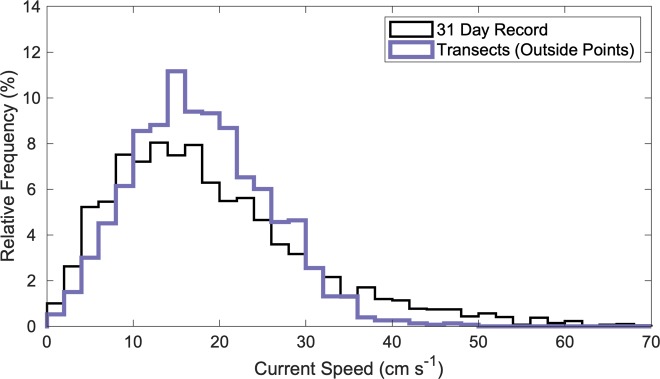
Current speeds on the Windmill Point summer sampling cruise compared to the one-month record.Transect measurements from outside the farm footprint (thick purple line) compared to the measurements collected by the ADP (thin black line).